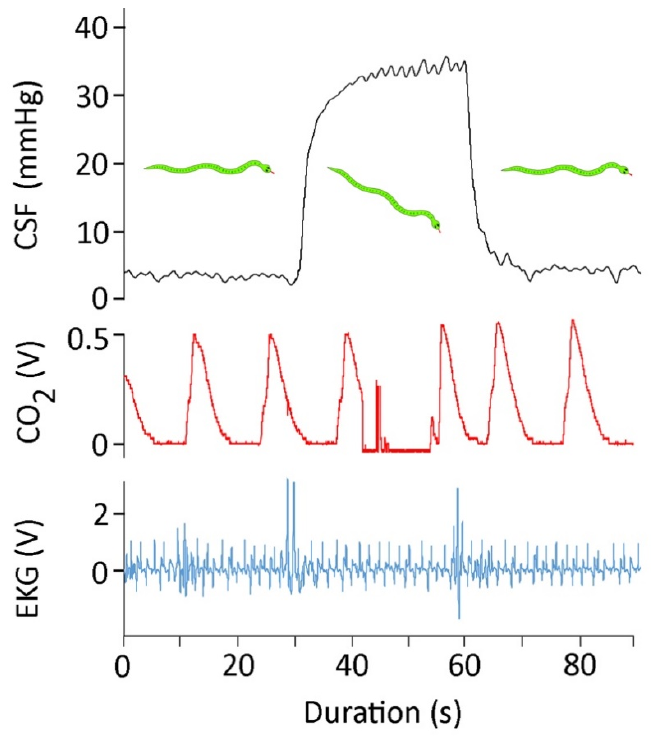
Figure 2. For 90 s, simultaneously recorded CSF pressure (black, upper trace), exhalatory CO 2 (red, middle trace), and EKG (blue, lower trace) from Candoia aspera . This 90 s trace includes approximately 30 s of horizontal posture; then, the snake was rotated 30 ◦ head-down and held for 30 s, and finally the snake was returned to the horizontal.